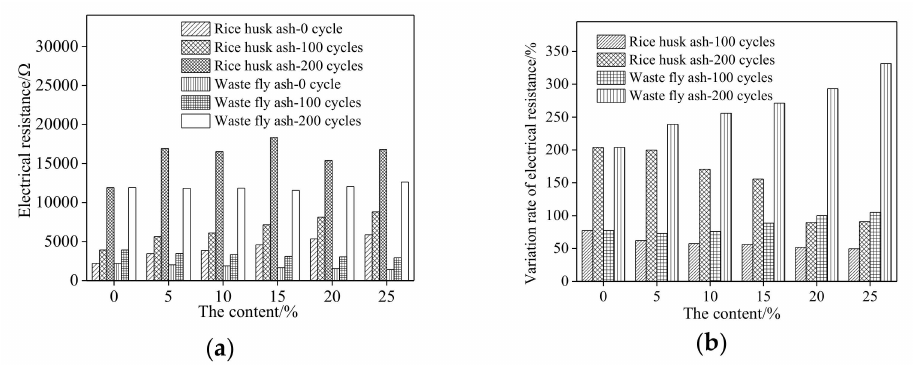
Figure 10. The electrical resistance of RPC during NaCl freeze–thaw cycles. ( a ) The electrical resistance. ( b ) The variation rate of